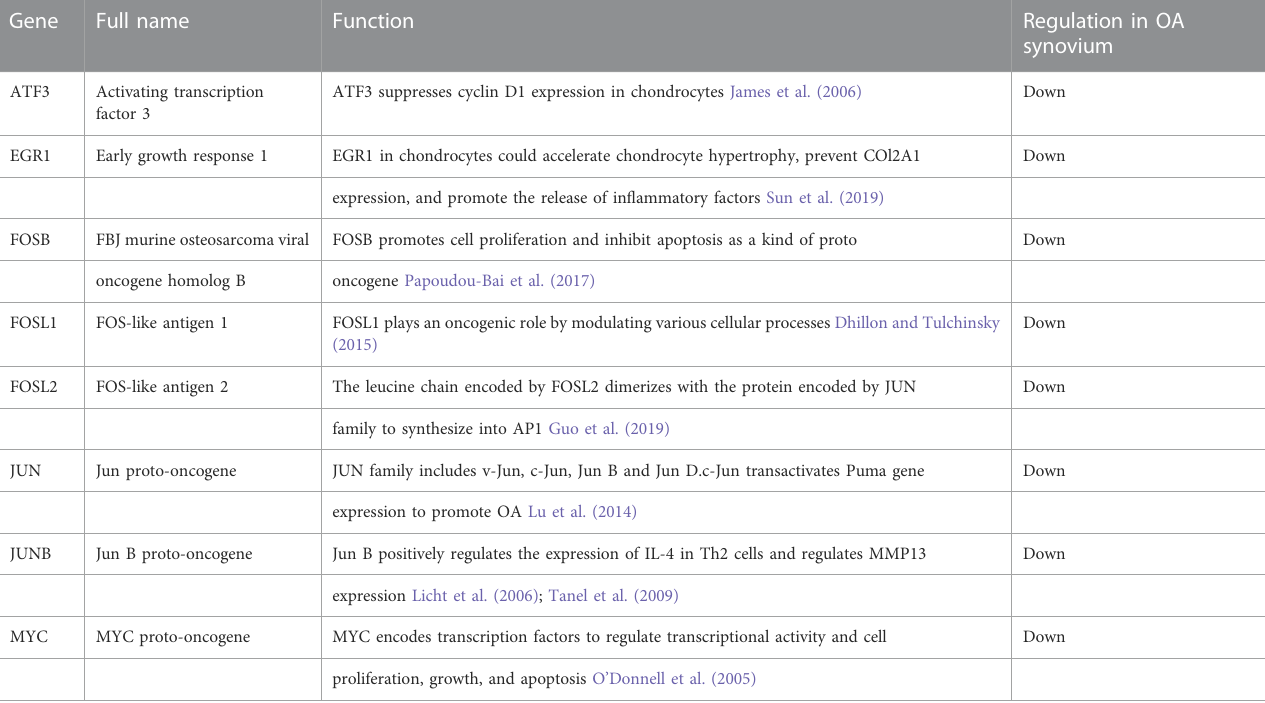
TABLE 3 Features and functions of 8 hub genes in OA screened from